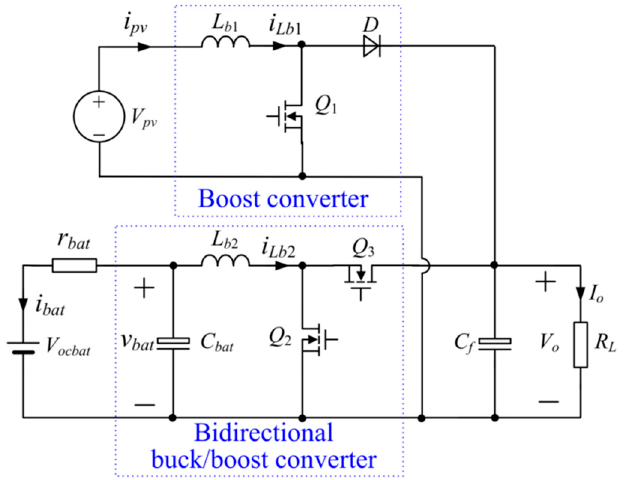
Figure 1. Main topology of the studied photovoltaic-based DC microgrid (PVDCM).